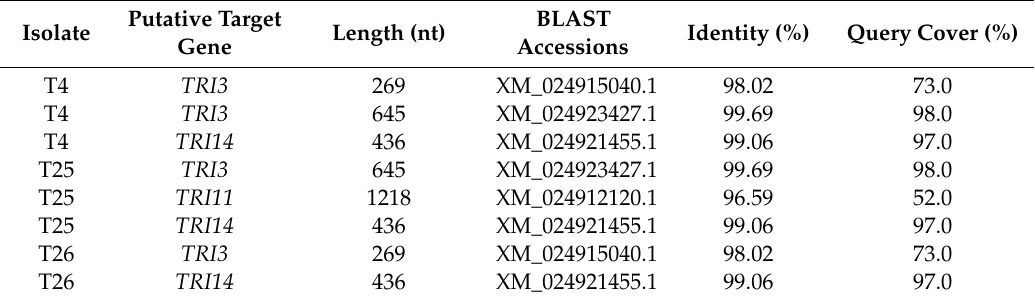
Table 2. BLAST best matches of the sequenced Tri genes amplicons from the Trichoderma spp. isolates.